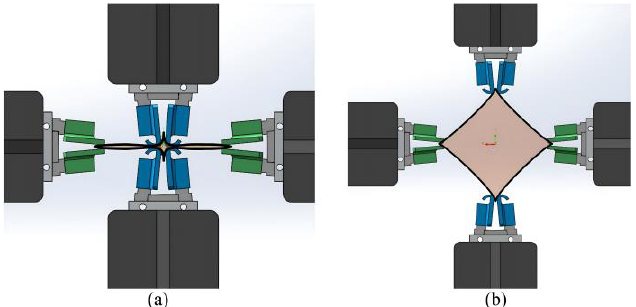
Figure 12. Net slackening mechanism working process: ( a ) Net sleeve finger clamping the net sleeve; ( b ) Net sleeve finger slack net sleeve.